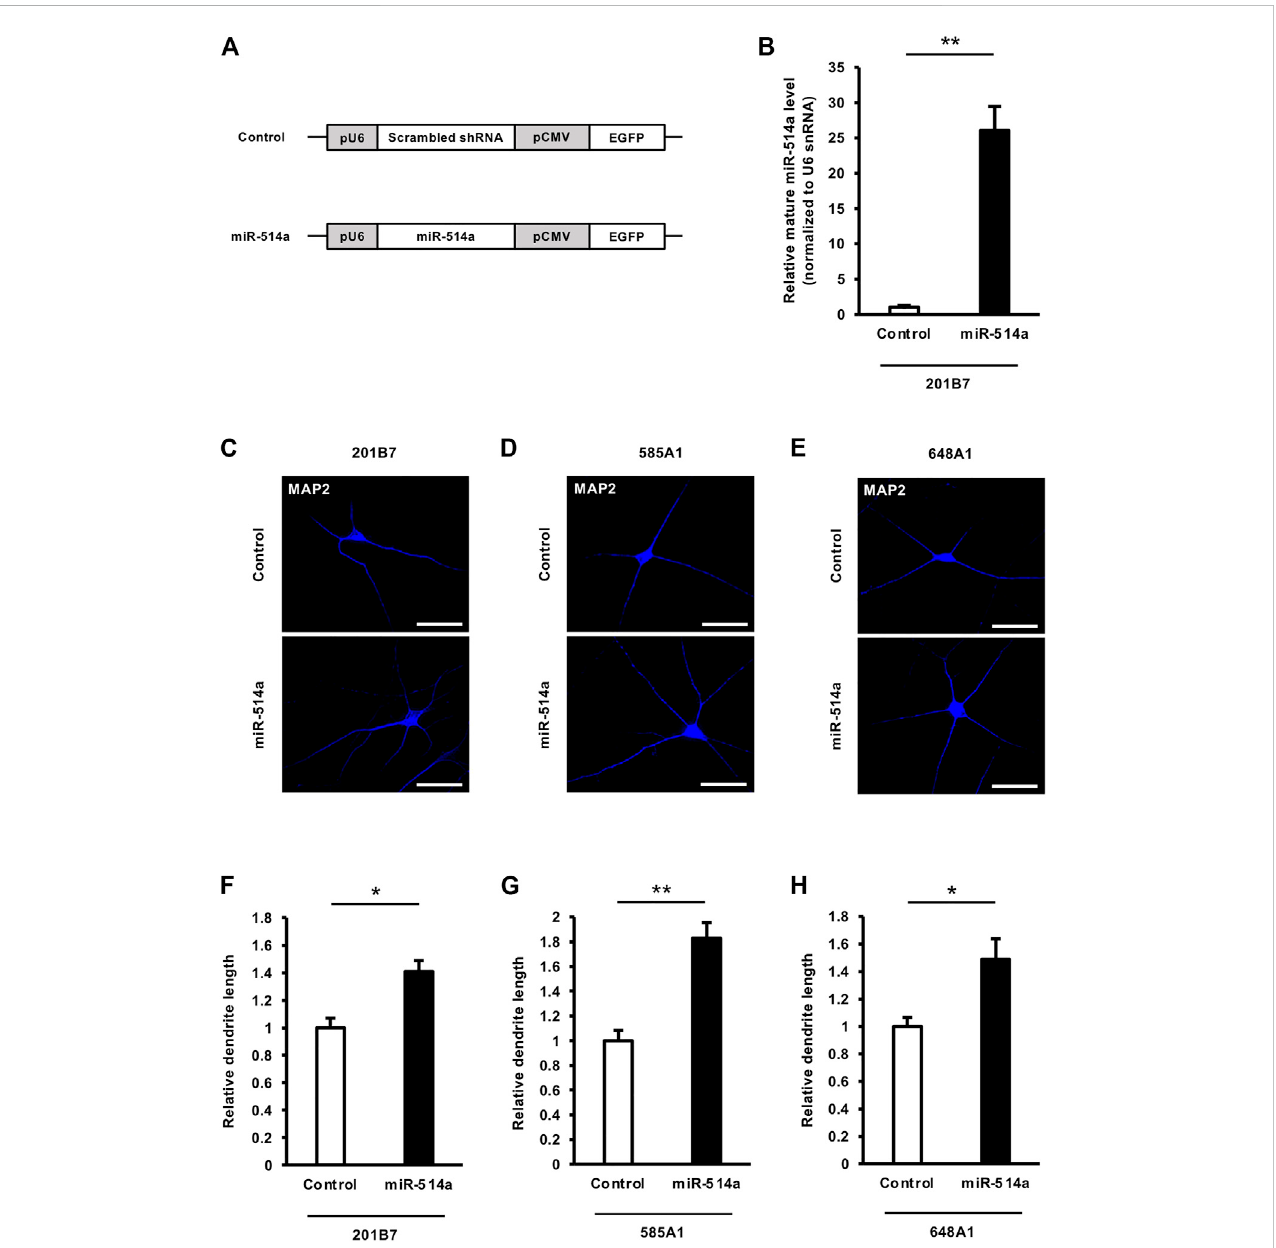
miR-514a promotes dendritic development in human iPSC-derived neurons. (A) Diagrams of lentiviral vector constructs. miR-514a is expressed as a short hairpin under the U6 polymerase - promotor, and EGFP is expressed under the CMV promotor. (B) Expression levels of mature miR-514a were con fi rmed using qRT-PCR. 201B7 iPSC-derived neurons were infected with lentiviruses expressing scrambled shRNA and miR-514a, respectively, and cultured for 7 days and subsequently lysed for qRT-PCR. n = 3 independent experiments. (C – E) Representative images of iPSC-derived neurons stained with anti-MAP2 (blue) antibody at 7 DIV. Scale bars, 50 µm. (F – H) Quantitative analysis of total dendrite length of neurons derived from three independent iPSC line, respectively. n = 3 independent experiments, at least 100 neurons were analyzed in each experiment. ** p < 0.01, * p < 0.05. Abbreviations: CMV, cytomegalovirus; EGFP, enhanced green fl uorescent protein; MAP2, microtubule-associated protein 2.